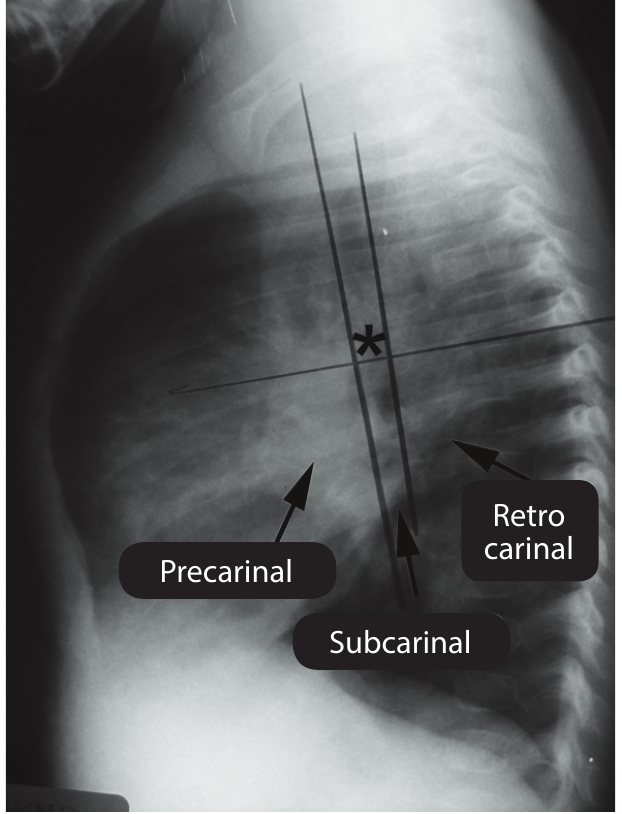
Fig. 1. Lines were drawn along the anterior and posterior tracheal margins as well as a horizontal (perpendicular) line below the right upper lobe bronchus (asterisk). Three zones were thus created below the horizontal line: precarinal, subcarinal and retrocarinal. Density can be seen in all three zones in this example, suggesting